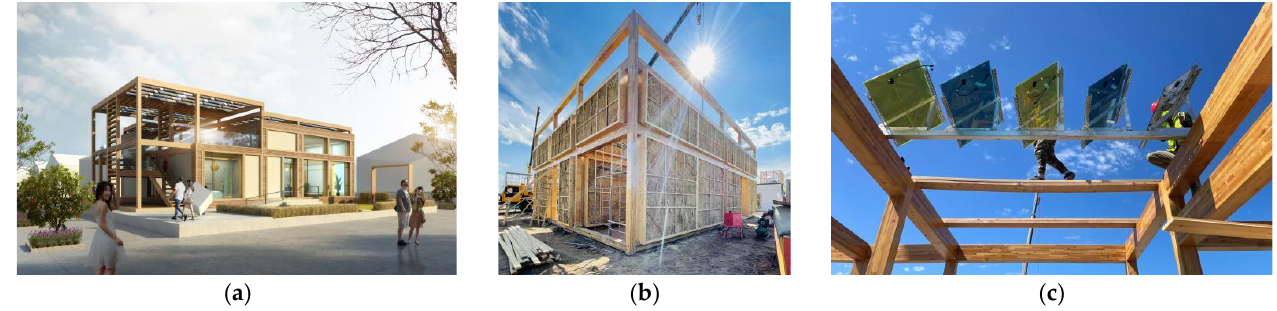
Figure 5. Main results of the Modular Sustainable Cube. ( a ) Straw bale modules. ( b ) Prefabricated materials. ( c ) PV panels.